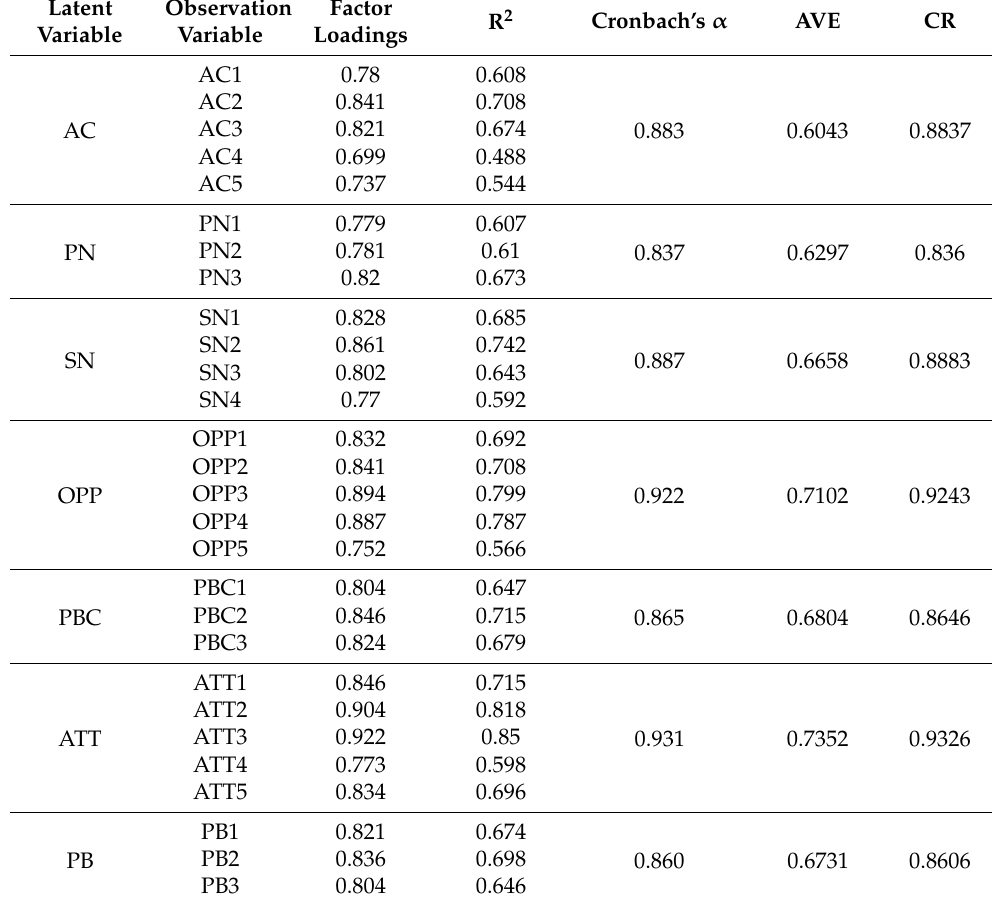
Table 3. Results of confirmatory factor analysis.